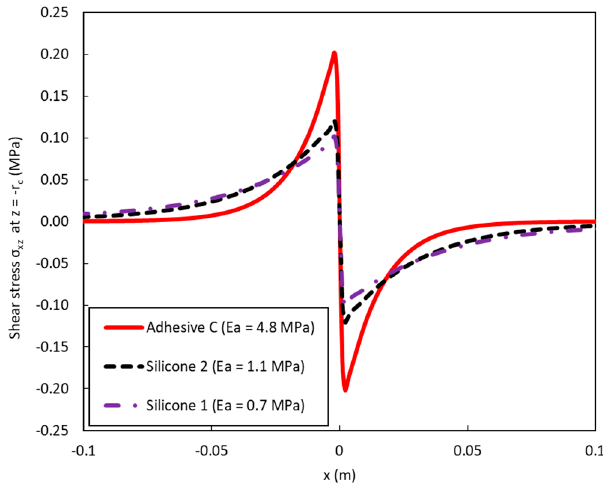
Figure 17. Numerical simulations of shear stress σ xz (x) at the adhesive/DOFS interface ( z = − r c ) considering opposite loads (0.045 MPa) applied to the two concrete blocks adjacent to the crack.